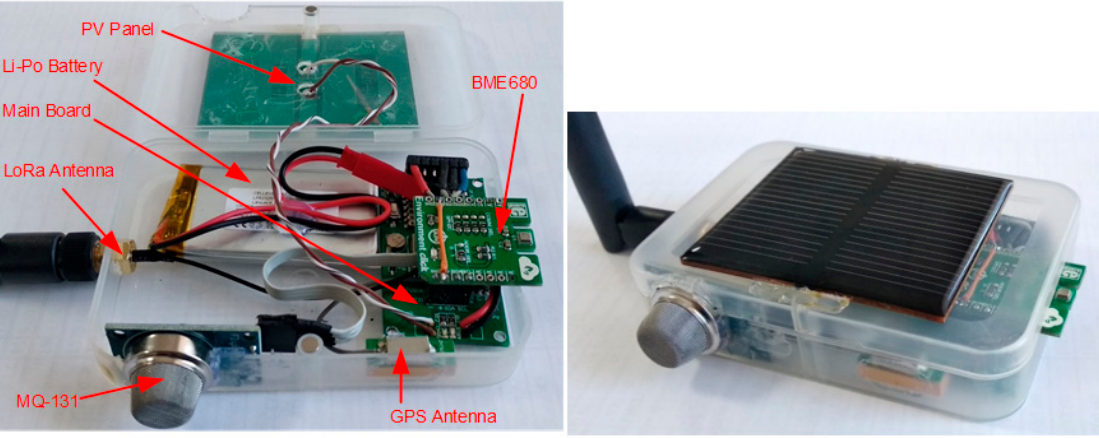
Figure 5. Hardware implementation of the MSMN node.